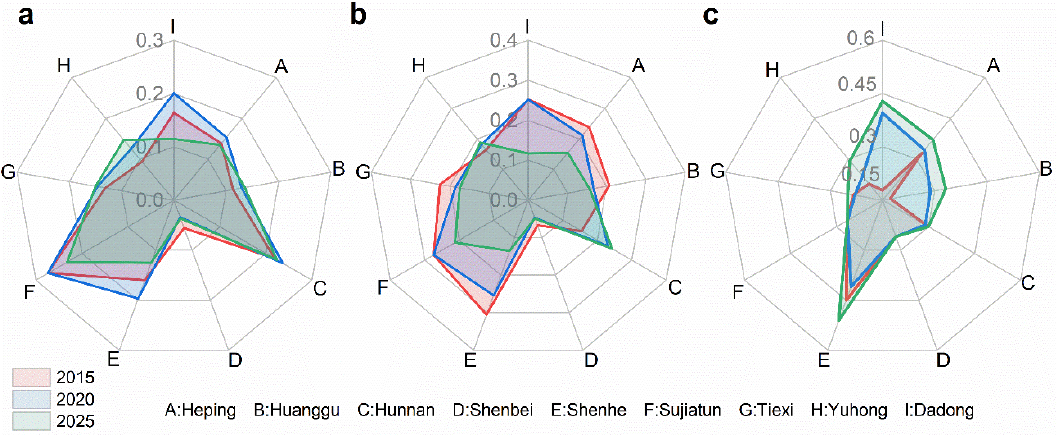
Figure 11. Comparison of equity of healthcare services through development of subway system: ( a ) the Theil index of quantity; ( b ) the Theil index of quality; ( c ) the Theil index of walking distance.